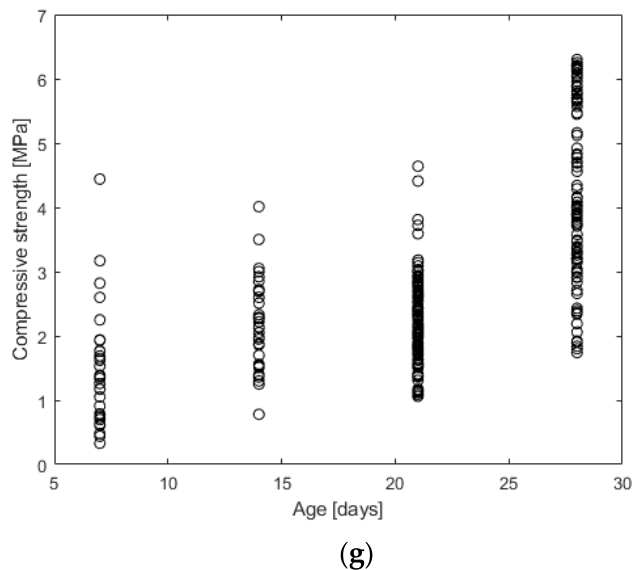
Figure 4. Relationship between each of the features of Database 1 (clay content ( a ), OMC ( b ), cement content ( c ), fibre content ( d ), fibre length ( e ), fibre tensile strength ( f ), age ( g )) and the corresponding compressive strength values. Table 4. Descriptive statistics of the features of Database